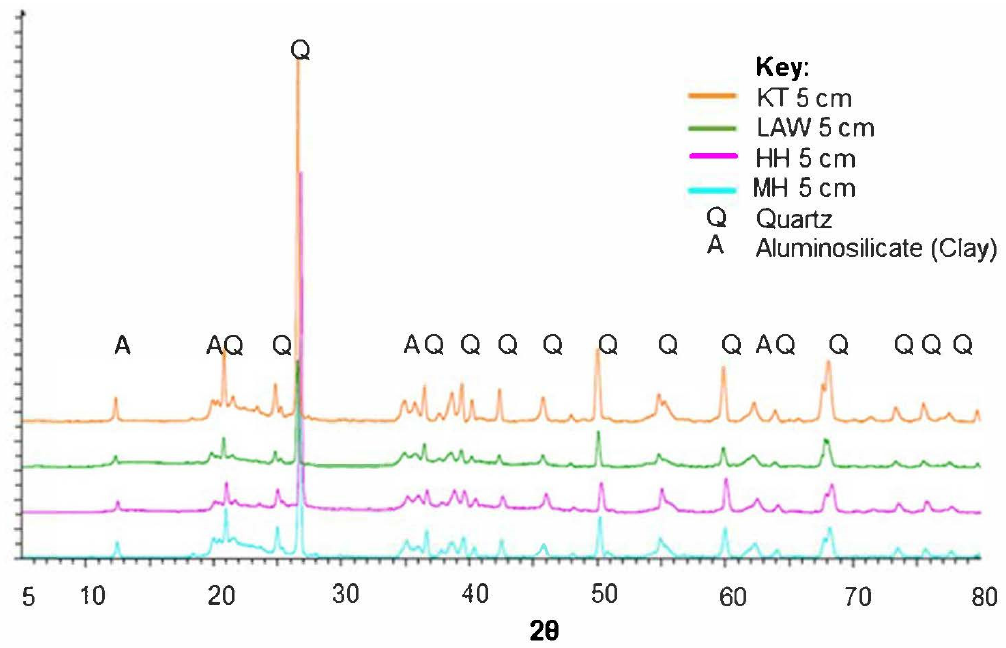
Figure 6. XRD spectra for surface sediment samples (0–5 cm) from naturally vegetated ( n = 4) Temperate Highland Peat Swamps on Sandstone (THPSS) catchments (from 5–80 degrees 2 θ ). Sites are indicated as Mount Hay (MH; light blue), Hat Hill (HH; pink), Lawson (LAW; dark green) and Kings Tableland (KT; orange). The y axis refers to intensity. Quartz is indicated as Q and alumino- silicate as A.